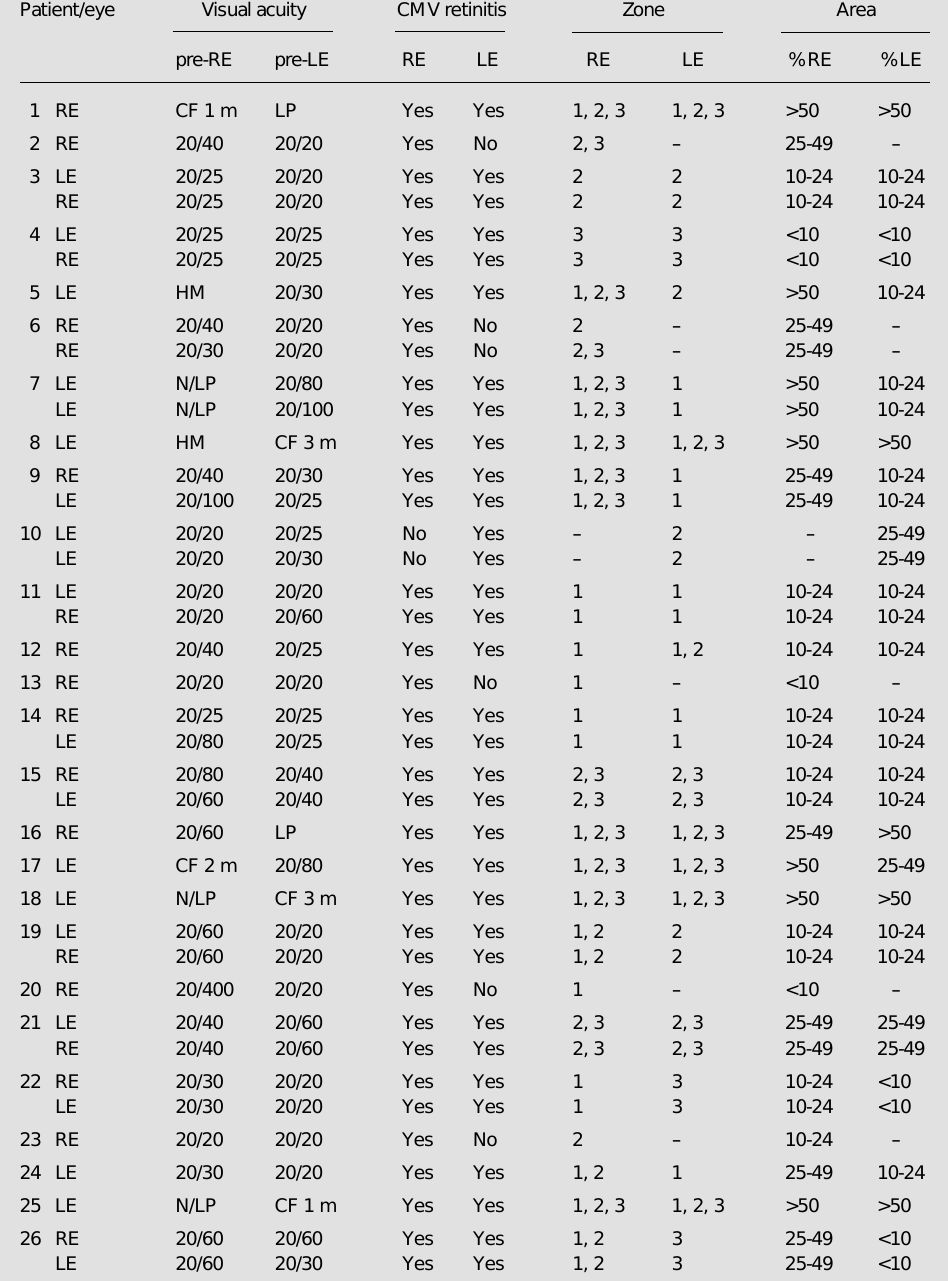
Table 1 - Patient, eye, pre-operative visual acuity, presence of cytomegalovirus (CMV) retinitis and retinal involvement. RE = Right eye; LE = left eye; visual acuity pre-RE = pre-operative visual acuity in the RE; visual acuity pre-LE = pre-operative visual acuity in the LE; Zone RE = retinal involvement in RE; Zone LE = retinal involvement in LE; Area %RE = percentage of retinal involvement in RE; Area %LE = percentage of retinal involvement in LE; CF 1 m, 2 m and 3 m = visual acuity of finger counts at 1, 2 or 3 m, respectively; HM = visual acuity of hand movements; N/LP = visual acuity of no light perception; LP = visual acuity of light